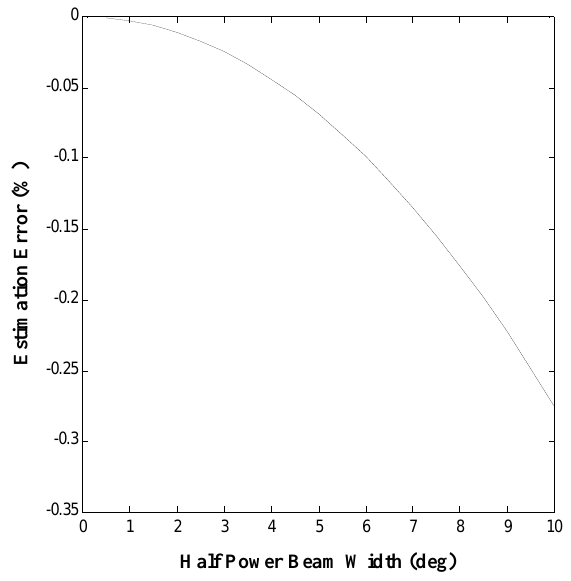
Fig. 3. Estimation error in the estimation of the vertical wind ve- locity in terms of a first moment of theoretical Doppler spectrum induced by vertical wind, in which the estimation error in unit of percentage is defined as ( V m − w)/w , where V m is the mean vertical wind velocity deduced from a first moment of the beam broadening spectrum and w is the true vertical wind velocity.